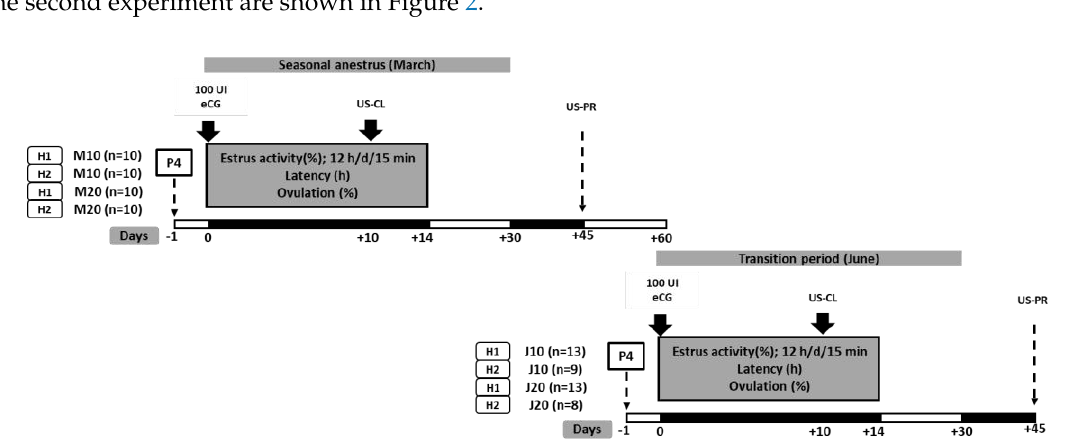
Figure 2. Experimental design of the ultra–short estrus synchronization protocol based on progesterone in crossbred (Saanen-Alpine-Nubian x Criollo) anestrous goats according to the month of the anestrous season. Note: H1 = herd 1; and H2 = herd 2. P4 = intramuscular injection of natural progesterone. M10 and M20, 10 and 20 mg of P4 were administered, respectively (at the beginning of seasonal anestrous); J10 and J20, 10, and 20 mg of P4 were administered, respectively (during the transition period to the reproductive season). Exogenous progesterone was administered intramuscularly. All females were treated with 100 IU eCG (Ceva SanteAnimale, Libourne, France), 24 h after P4–administration luteum at d 7 after the estrus peak, an US–PR = pregnancy was evaluated at 45 d after buck